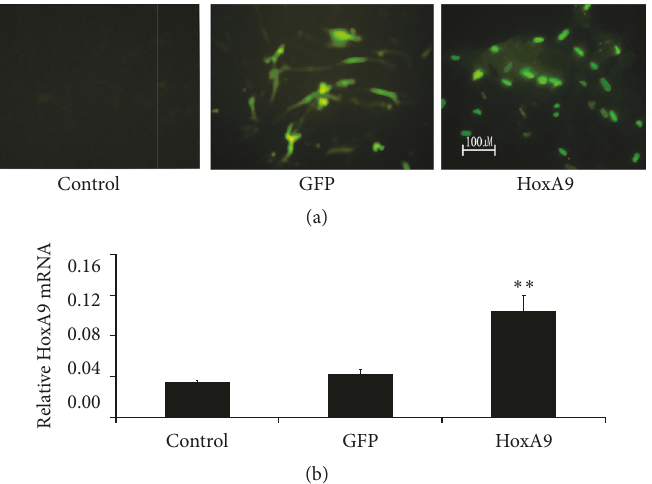
Figure 4: HoxA9 expression in lung was determined by fluorescence microscopy (a) and real-time PCR ( 𝑛 = 4 , (b)). HoxA9 expression located in the nucleus and increased markedly at 24 hours after pLenO-Hox A9 infection. ∗∗ 𝑃 < 0.01 versus control or